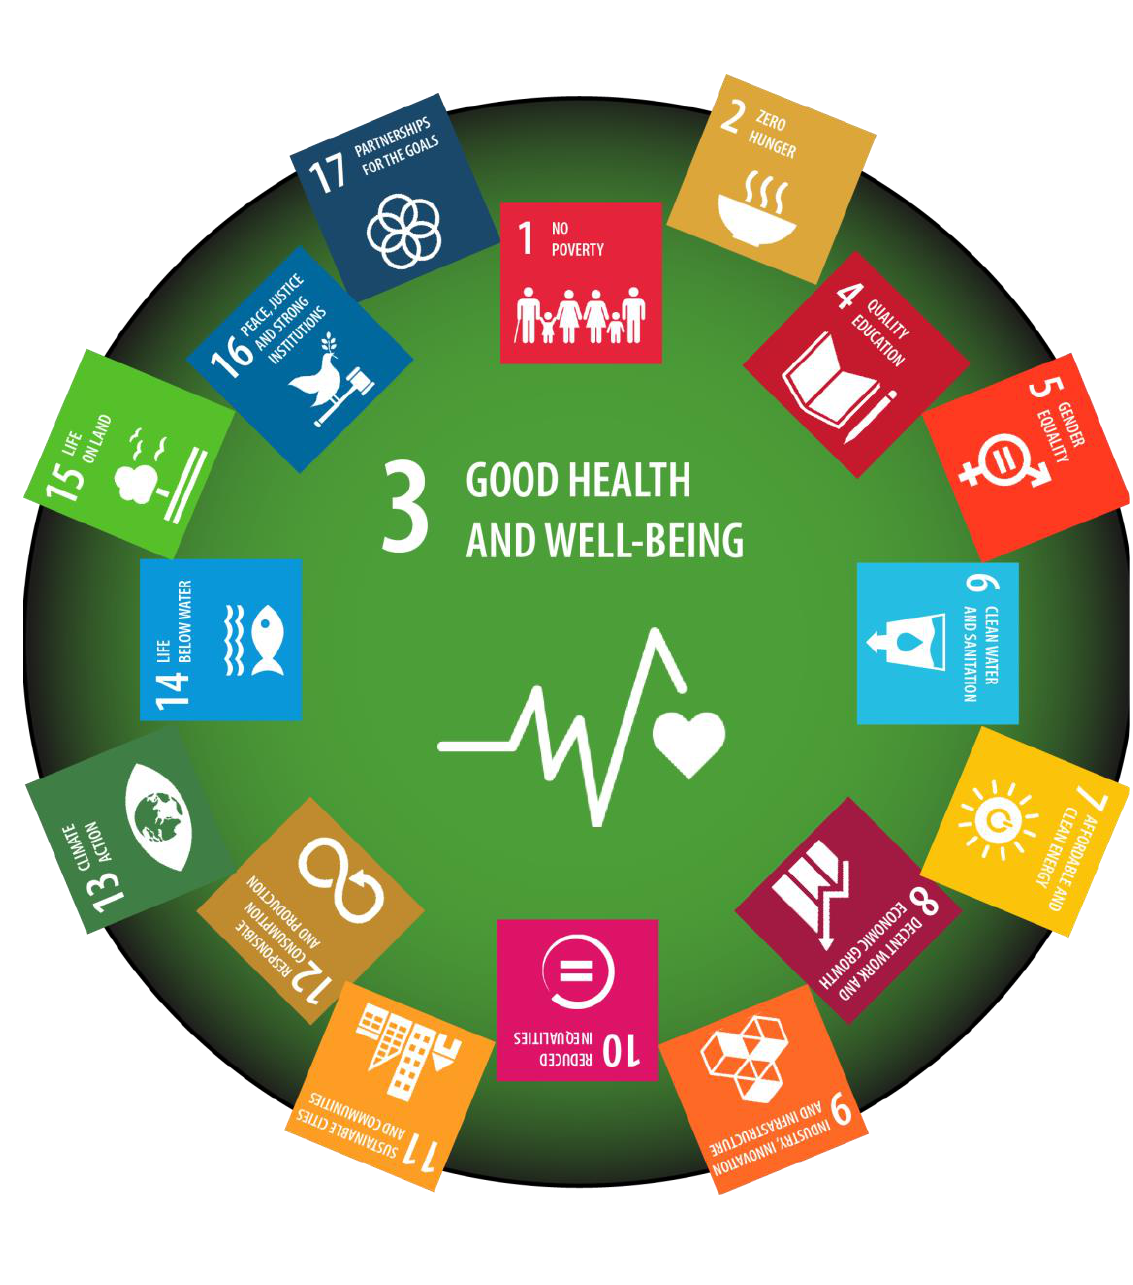
Figure 1: Sustainable Development